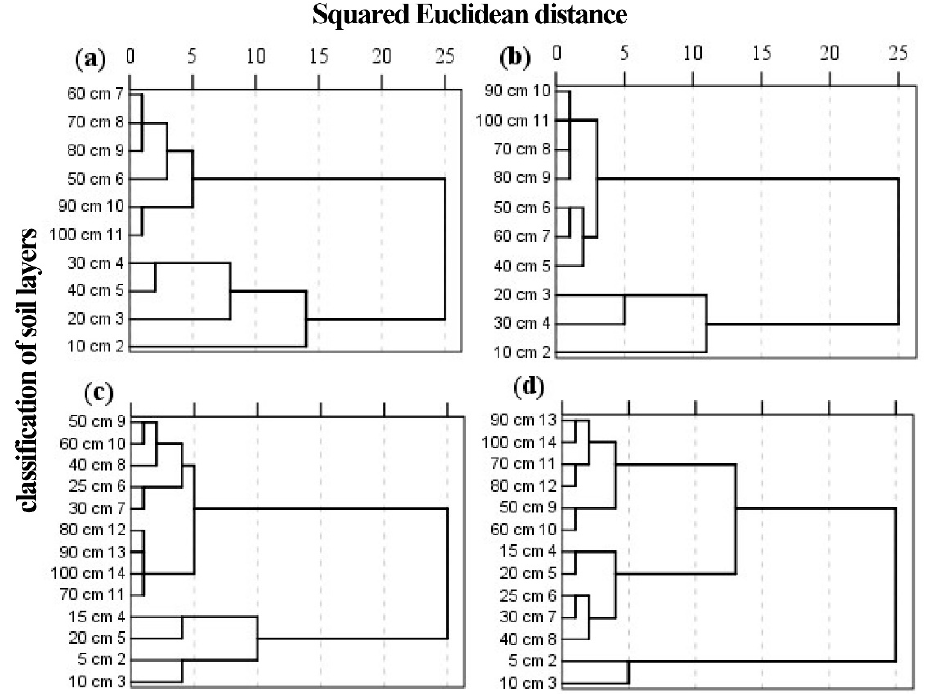
Figure 3. Soil cluster analysis using δ 18 O values. x -axis, Squared Euclidean distance; y -axis, Soil depth (0–100 cm); ( a ) Arid region; ( b ) Semi-arid region; ( c ) Semi-humid region; ( d ) Humid region. The length of the black line represents the size of squared Euclidean distance, the nodes represent soil layers that have the nearest distance and were clustered into one group.